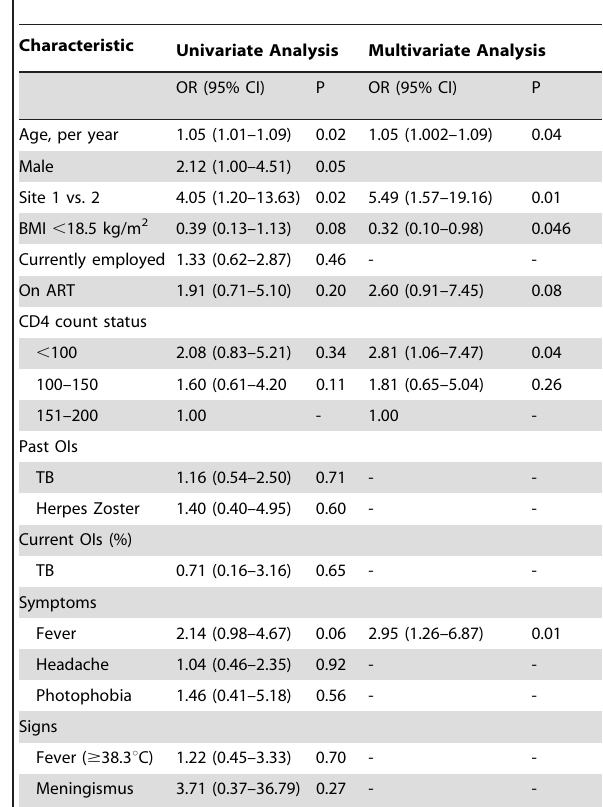
Table 2. Univariate and multivariate analysis of risk factors for cryptococcal antigenemia among HIV infected patients in Addis Ababa, Ethiopia